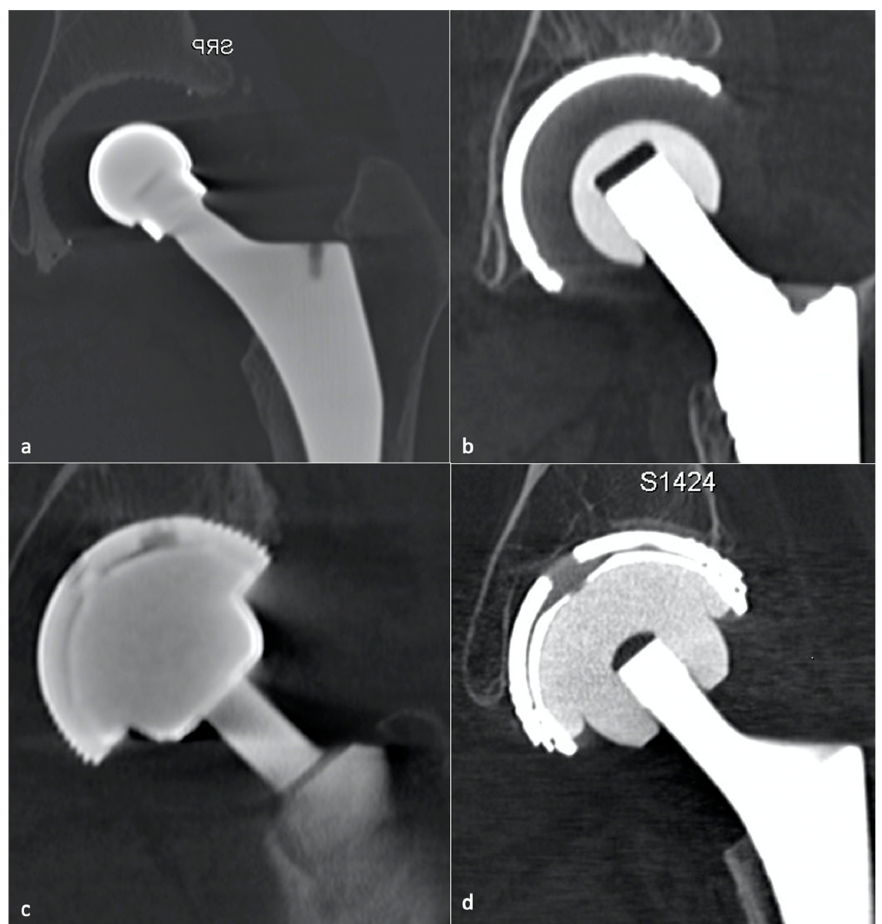
Figure 4. Bearing surfaces. Coronal slices of CT-scan showing on ( a ) a metal–polyethylene couple, ( b ) a ceramic–polyethylene couple, on ( c ) a metal–metal couple, and on ( d ) a ceramic–ceramic